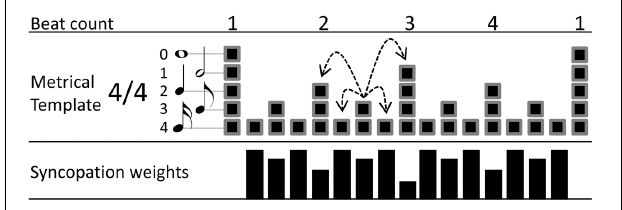
FIGURE 1 | Example of a 4/4 metrical template used in the SG calculation of the amount of syncopation. At the bottom, the syncopation weights for each metrical position are shown as black bars. The dashed arrows depict the amplitude differences for the 8th note of the second beat in the bar, as an example of the amplitude differences taken for each metrcial position during the calculation of the